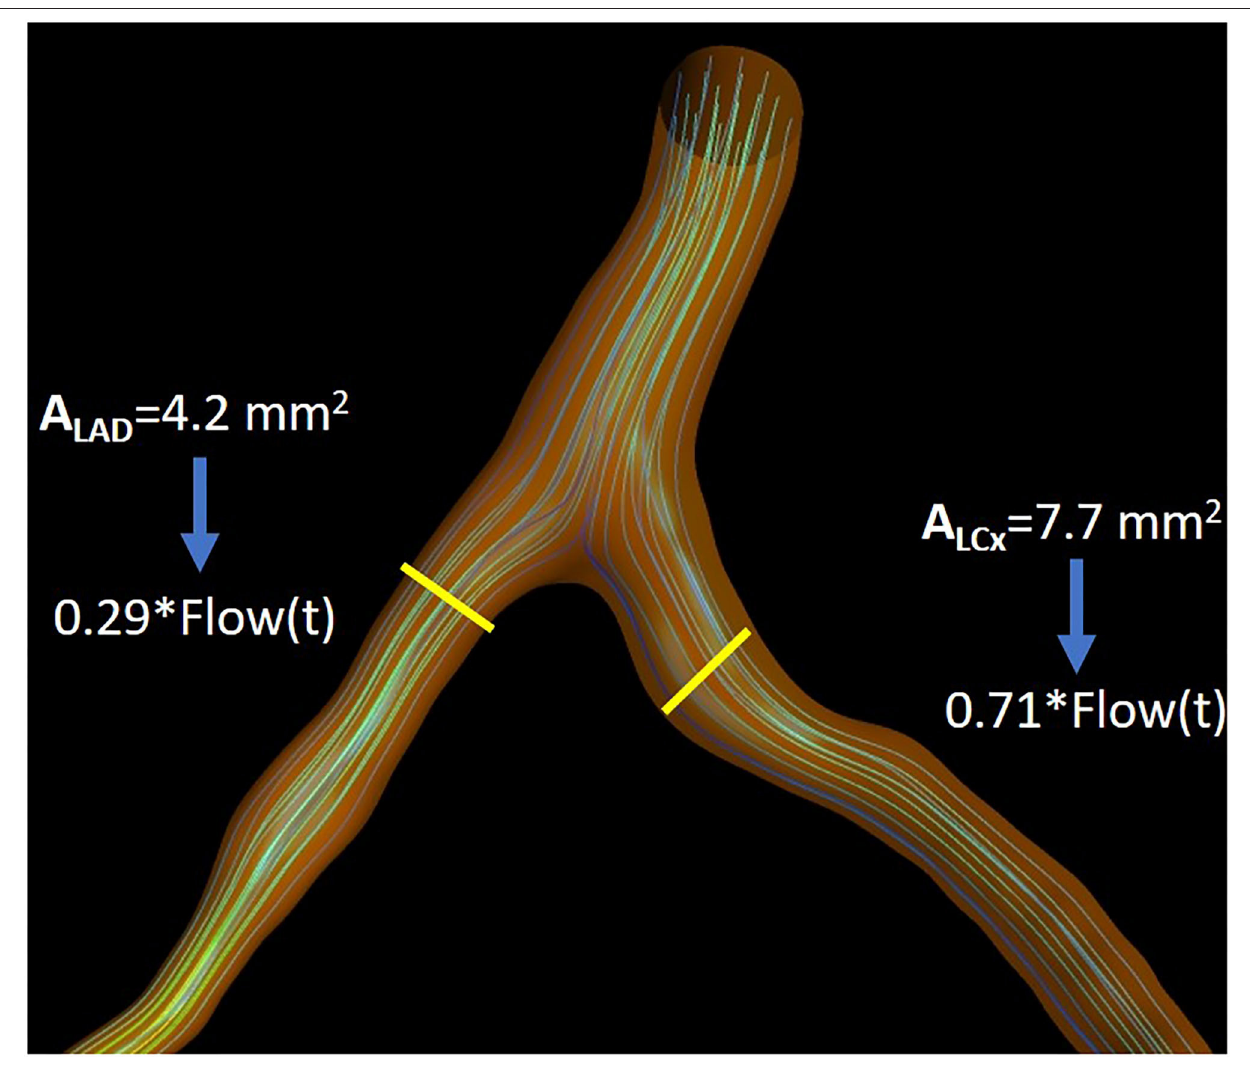
FIGURE 3 | Illustration depicting the flow separation ratio as calculated for an indicative case, as calculated by Murray’s